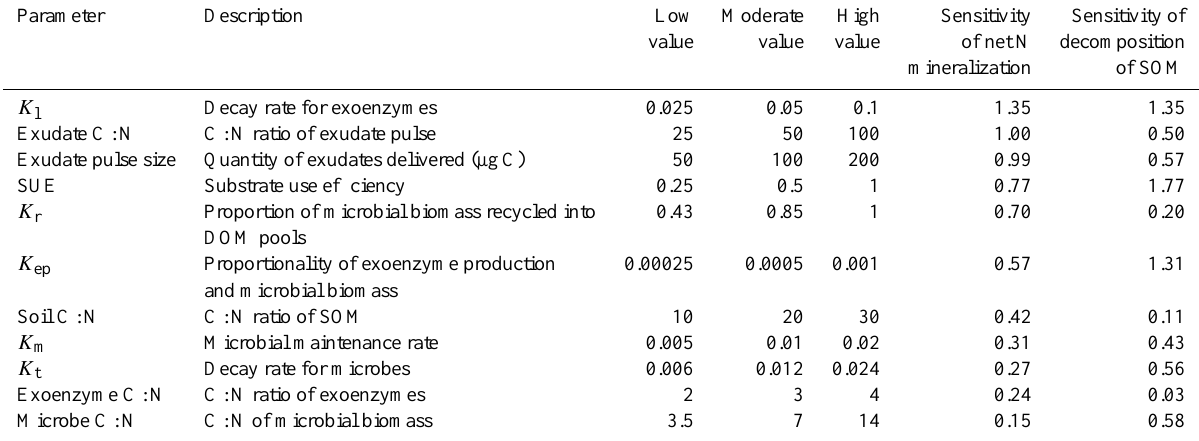
Table 1. Parameter sensitivity analysis of modeled net N mineralization and SOM decomposition following an exudate pulse. Parameter Description Low Moderate High Sensitivity Sensitivity of value value value of net N decomposition mineralization of SOM K l Decay rate for exoenzymes